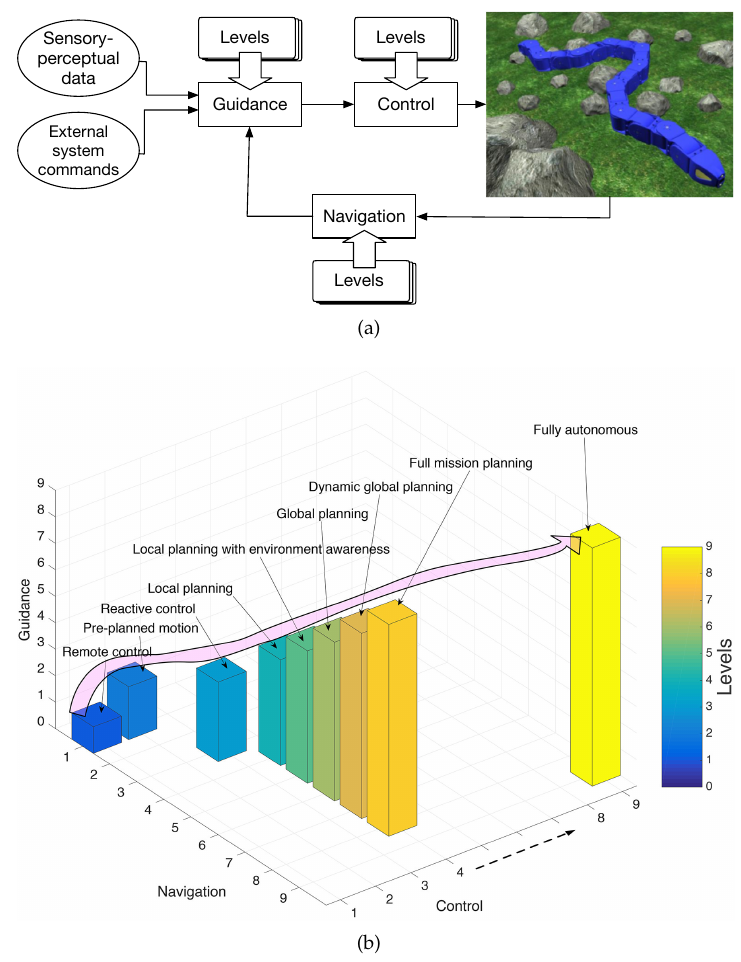
Figure 5. ( a ) Information flow through the different functions and capabilities of guidance, navigation, and control (GNC); ( b ) the possible design levels depicted in Figure 4 are represented in a three-dimensional